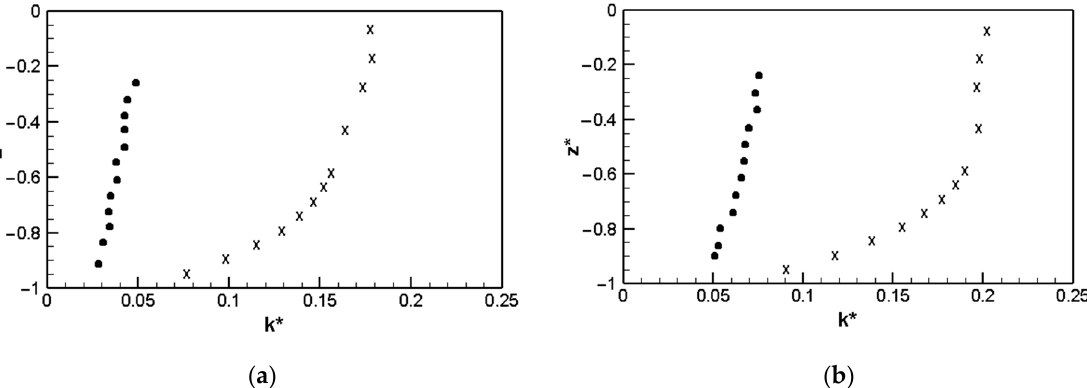
Figure 9. Result 4: time mean turbulent kinetic energy profiles in Configuration WKC, showing numerical results (X) and experimental results (circles) [3]. ( a ) x = 7.27 m, ( b ) x = 7.88 m, z ∗ = ( z − η ) / H and k ∗ = k / gH .